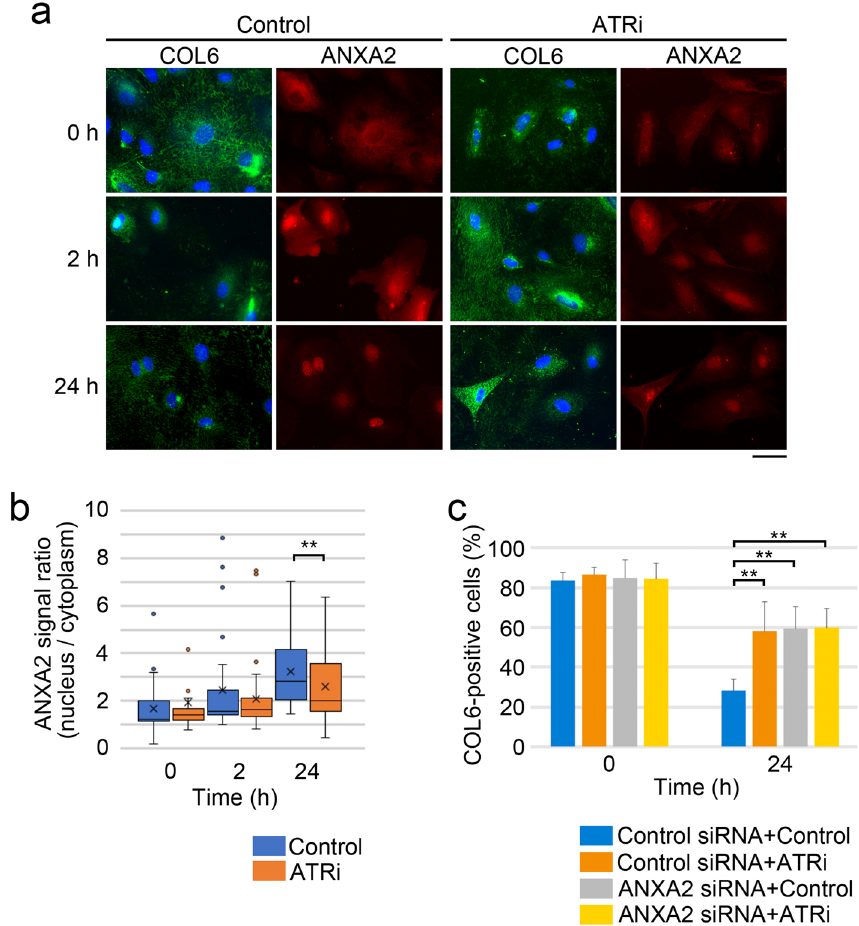
Figure 5. ATR may link to ANXA2 in MMc-induced COL6 secretion. ( a ) HRGECs were cultured with DMSO (control) or ATRi for 1 h, then MMc (12 µg/mL) was added in the cultures. Two h after MMc addition, the cells were washed and cultured with or without ATRi for the indicated number of hours. The cells were immunostained with anti-COL6 and anti-ANXA2 antibodies. Scale bar: 50 µm. ( b ) The ANXA2 signal ratio (nucleus/cytoplasm) were measured for more than 25 cells using the samples of a . ( c ) HRGECs transfected with control or ANXA2 siRNA were cultured with DMSO (control) or ATRi for 1 h, and then MMc (12 µg/mL) was added in the cultures. Two h after MMc addition, cells were washed, and cultured with or without ATRi for the indicated number of hours. The cells were immunostained with anti-COL6 antibody. The percentage of cells with cytoplasmic COL6 (COL6-positive cells) was measured by fluorescent images. A total of more than 100 cells of four independent fields per experiment was analyzed. ( b , c ) Statistical significance was determined by the Mann–Whitney U test. ** p <